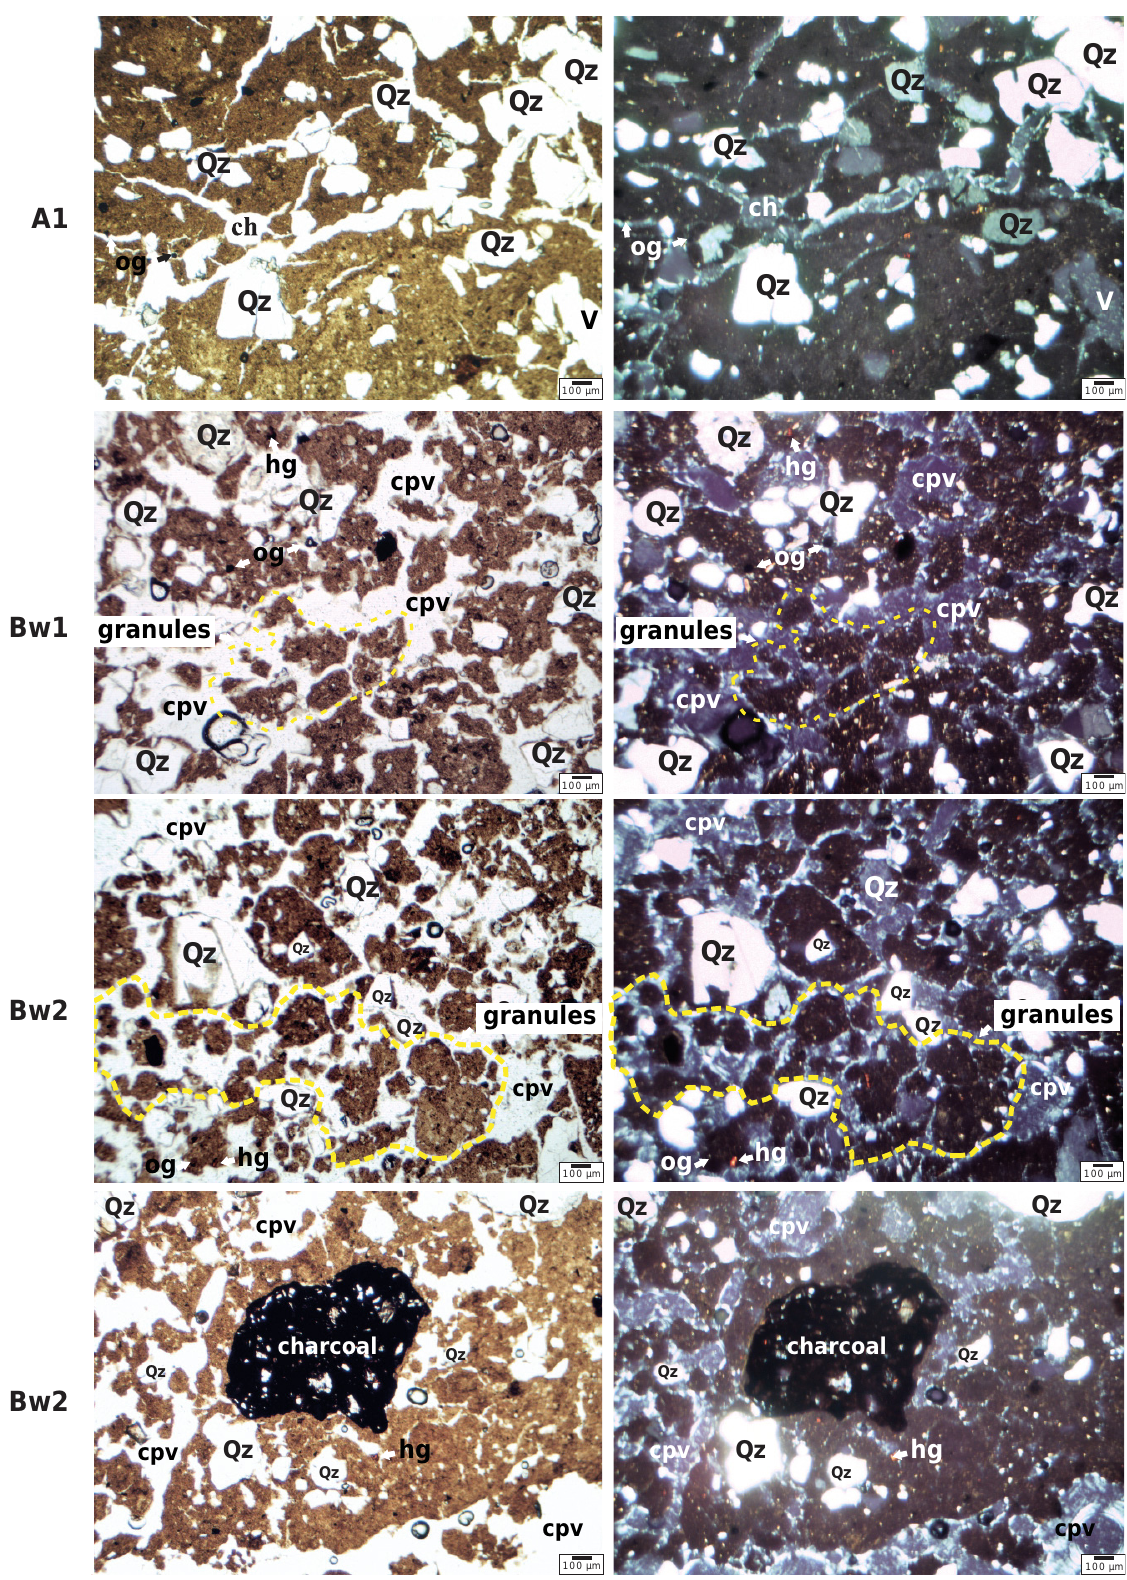
Figure 6. Optical microscope photomicrographs (OMP) in parallel (left) and crossed polarized light (right) of the P1 profile, highlighting: A horizon = sub-angular blocky microstructure with groundmass composed by angular/sub-angular quartz and opaque grains (coarse materials) and brownish yellow micromass with undifferentiated or weak speckled b-fabric; Bw1 horizon = granular microstructure with enaulic relative distribution. The coarse materials of the groundmass are composed of angular/sub- angular quartz, hematite, and opaque grains, and the micromass is brownish yellow with a circular or crescent striated b-fabric; Bw2 horizon = medium granular and vughy microstructure, with the same coarse materials and micromass of the Bw1 horizon. The presence of large charcoal fragments inter-aggregates and very small fragments inside them is common. Qz = quartz; V = vughy; cpv = complex packing voids; hg = hematite grain; op = opaque grain; ch = channel. Some granular aggregates of Bw (1 and 2) horizon are highlighted with a dashed yellow